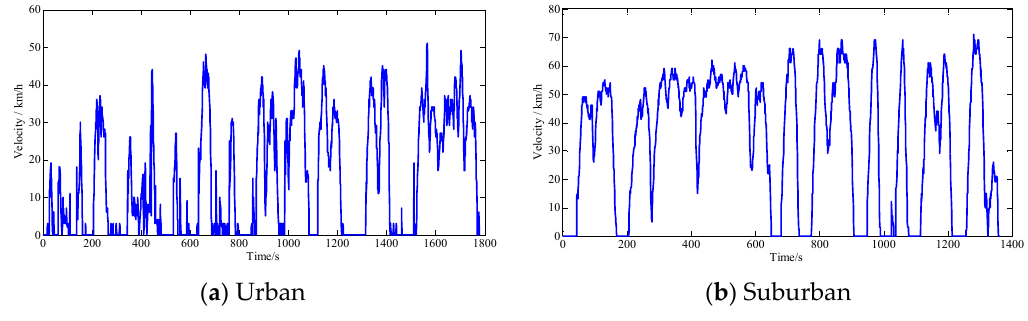
Figure 2. Driving conditions of Zibo City. Table 4. Statistical analysis of real-road driving